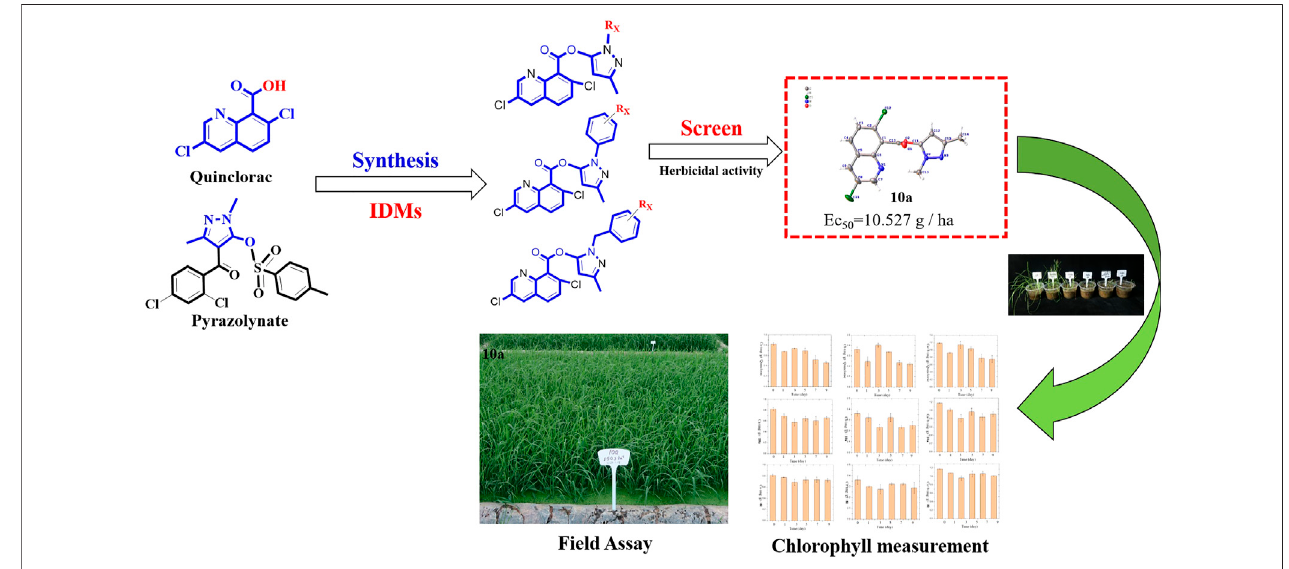
FIGURE 1 | Design of the target